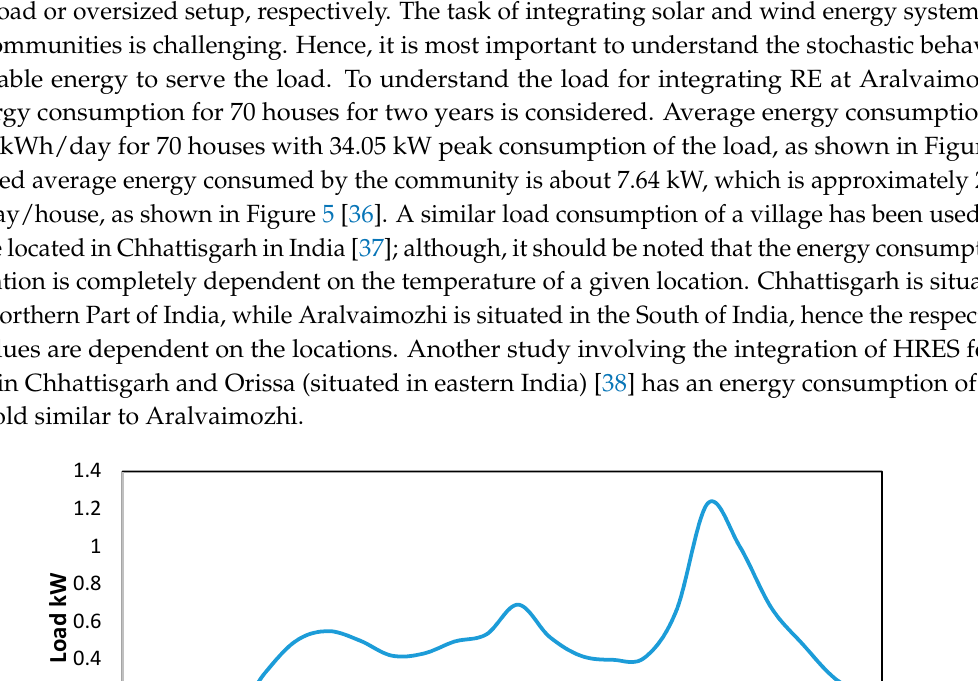
Figure 4. Solar and wind energy availability at Aralvaimozhi, India.